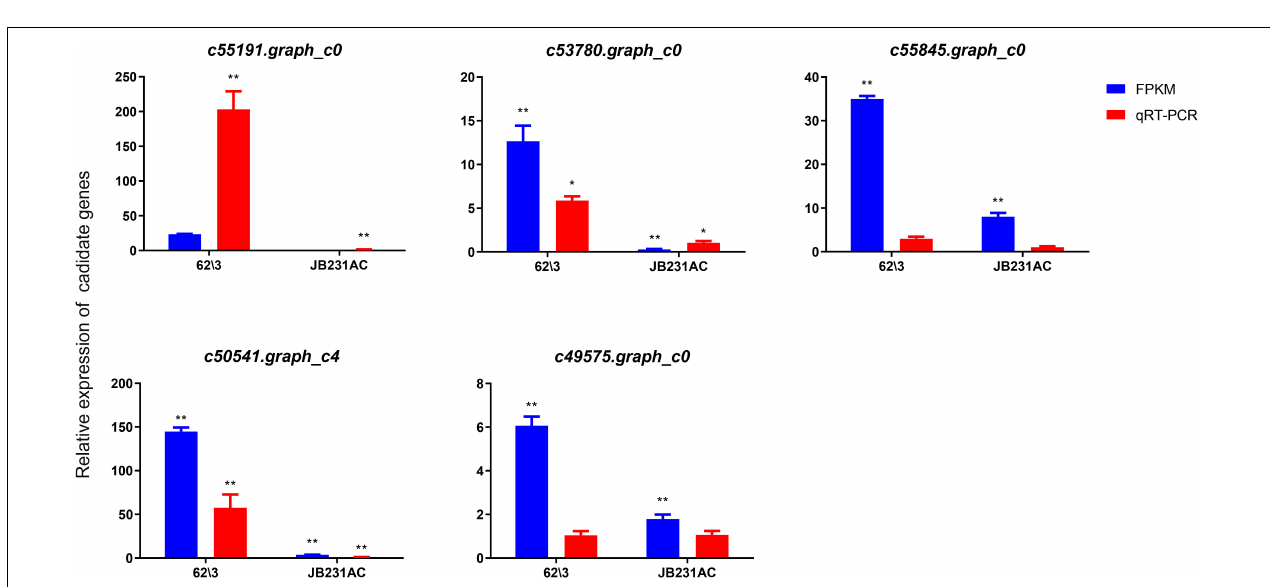
FIGURE 7 | Cluster heat maps of DEG expression of 62\3 and JB231AC under 50 µ M Cd stress. (A) Predicted ATP-binding cassette ( ABC ) gene expression. (B) Predicted ZIP (Zn-regulated transporter, Iron-regulated transporter-like protein) gene expression. Expression values of two cultivars were presented as log 2 -transformed normalized FPKM (Fragments Per Kilobase of transcript per Million mapped reads) values, and FPKM value was average of three replicates. Additional details are presented in Supplementary Tables 6 , 7 .